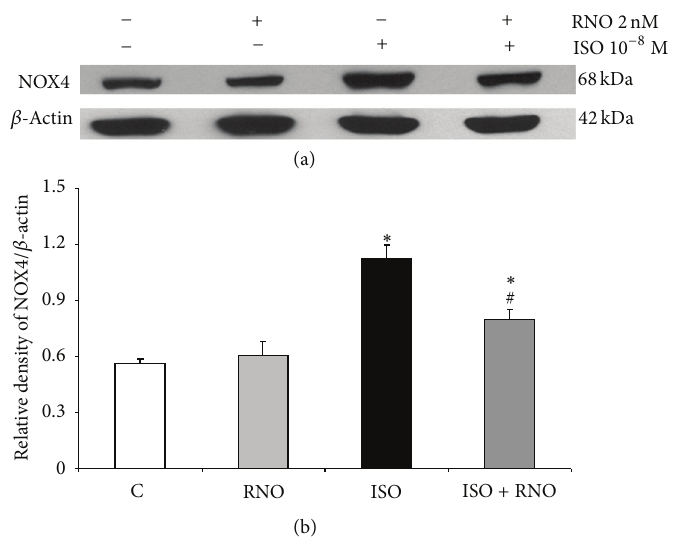
Figure 7: Effect of 8-epi-PGF 2𝛼 and RNO on NOX4 expression in HLF. Cells from 3 separate donors were preincubated or not with RNO (2nM) and then treated for 24h with 8-epi-PGF 2𝛼 (10 −8 M). (a) Protein expression of NOX4 was analyzed by Western blotting. (b) Quantification of protein was expressed as a ratio to 𝛽 -actin. Data are mean ± SD of 3 experiments. ∗ 𝑃 < 0.05 versus control (C); # 𝑃 < 0.05 versus BLM.